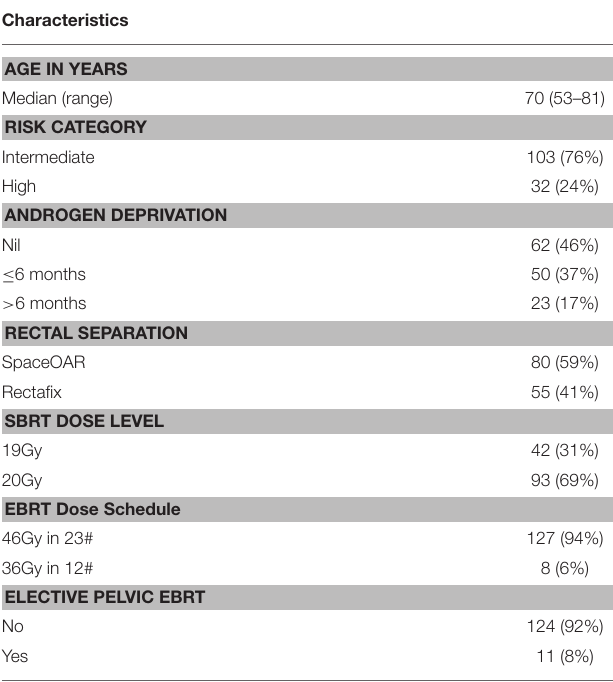
TABLE 2 | Patient characteristics ( n =